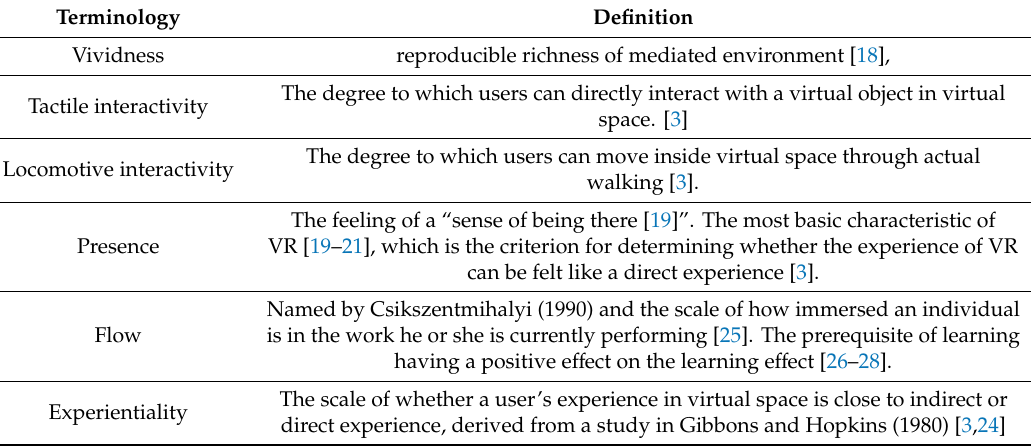
Table 1. Definition of terminology from the empirical recognition scale by Kwon (2020) [10]. Copyright © 2020, Springer-Verlag London